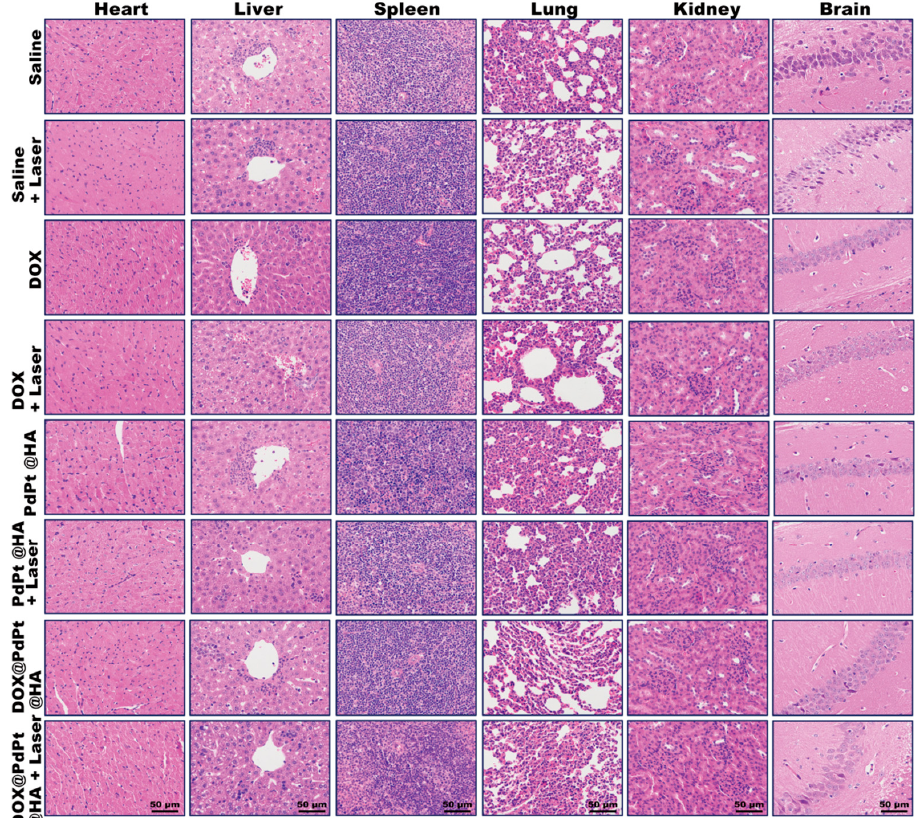
Figure 7. Representative H&E staining images of heart, liver, spleen, lung, kidney and hippocampal CA1 region in brain from animals with different treatments.